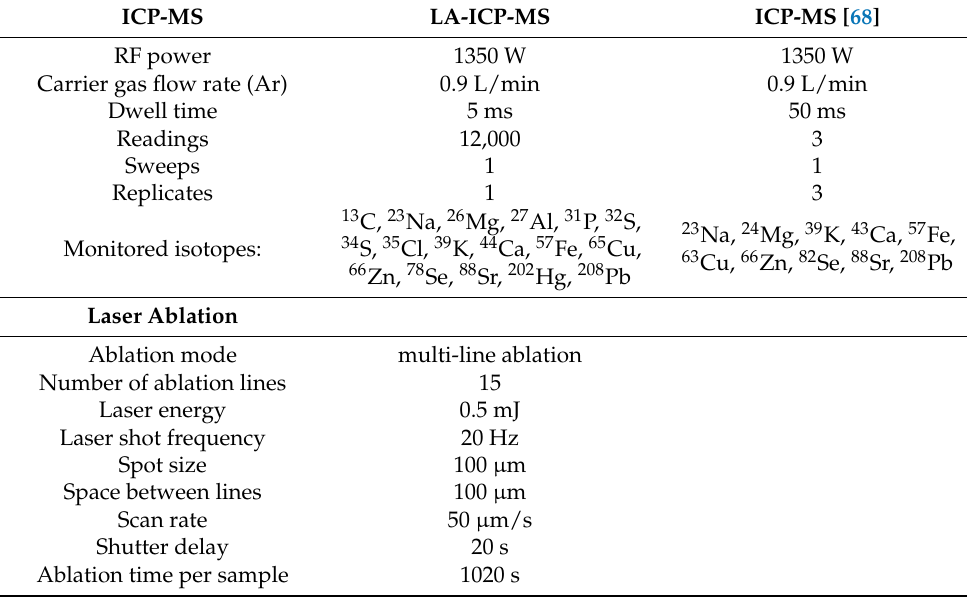
Table 2. LA-ICP-MS instrumental